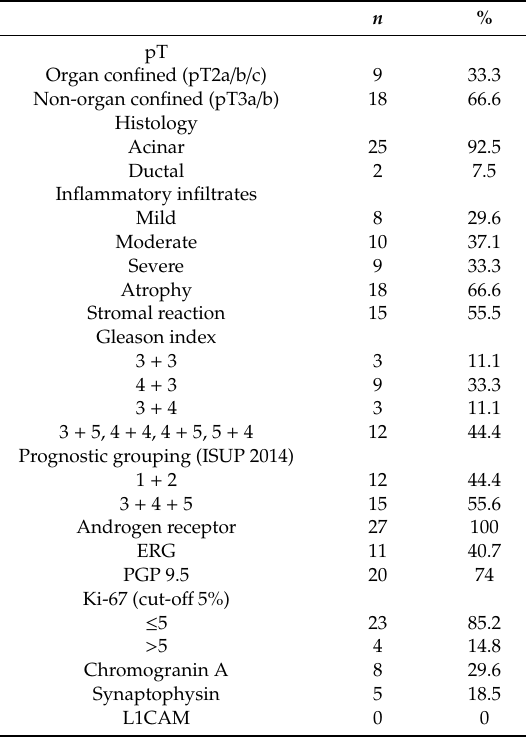
Table 2. Pathological findings in 27 oligometastatic prostate